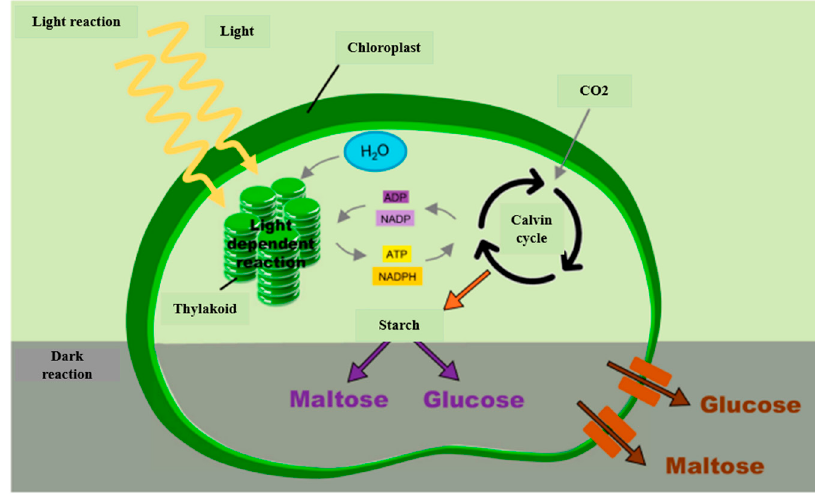
Figure 11. The overall process of photosynthesis at the chloroplast level [107]. Chlorophylls are the primary pigments in crop cells that absorb sunlight in the blue (450 nm) and red (650 nm) wavelengths and give the crop its green color. However, there are other pigments in crop cells, namely carotenoids, which absorb blue light and give the leaves their yellow color. Furthermore, the excitation of ions in the process of photosynthesis is driven by the absorption of specific wavelengths of light in the visible range [103], as shown in Figure 12.